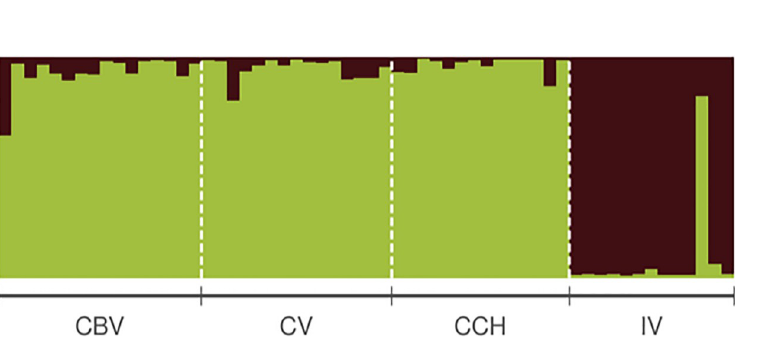
Fig 6. Individual assignment of timberline wren genotypes to one of two clusters defined by STRUCTURE and the evanno method. Bars represent individuals and colors depict percentage admixture from two different clusters. Populations: CBV = Cerro Buena Vista, CV = Cerro Vueltas, CCH = Cerro Chirripo´, IV = Irazu´